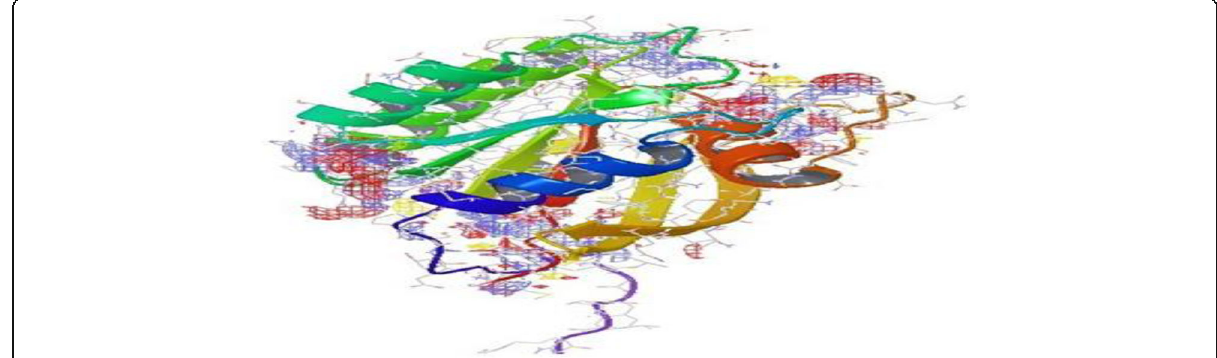
Fig. 8 Active site of Rab39a obtained from Sitemap module [23]: The hydrogen bond acceptor region is indicated in red, H-bond donor regions in blue and hydrophobic pockets in yellow color